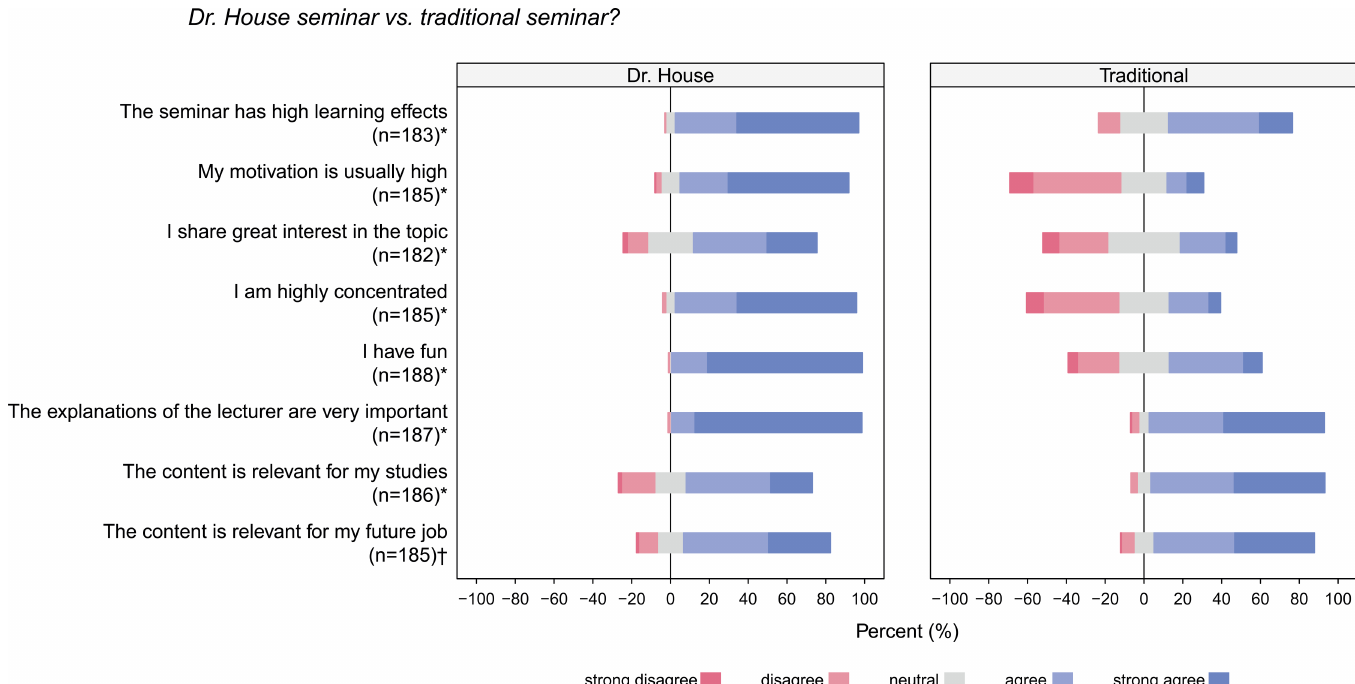
Fig 3. Comparison of Dr. House seminars to a traditional seminar. (cid:3) Difference is significant p < 0.001; † Difference is significant p < 0.05.